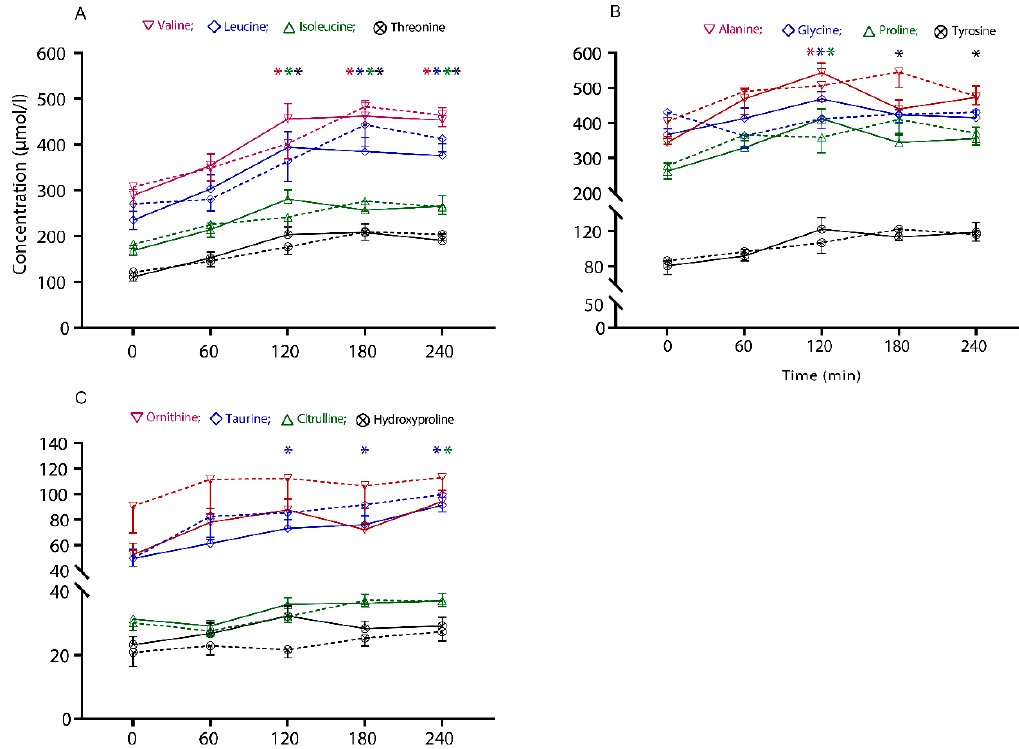
Figure 2. The concentrations of plasma-free amino acids across the intervention period in response to the two treatment arms, SV: sous-vide (solid lines); PF: pan-frying (dashed lines). The values are presented as mean ± SEM concentration ( µ mol / l) of ( A ) essential amino acids (valine, leucine, isoleucine and threonine), ( B ) nonessential amino acids (alanine, glycine, proline and tyrosine), and ( C ) nonproteogenic amino acids (ornithine, taurine, citrulline and hydroxyproline). Comparisons